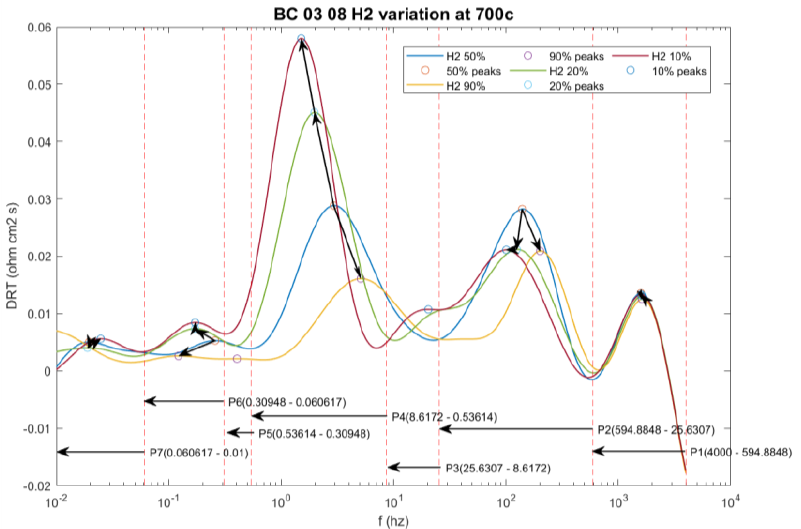
Figure 6. Tool user interface illustrating hydrogen variation analysis.